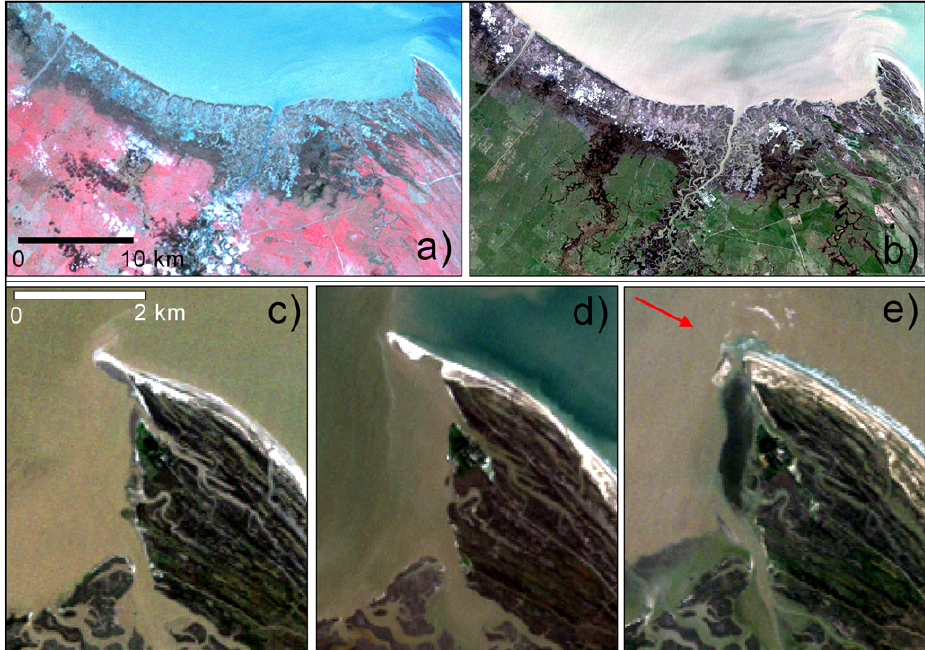
Fig. 5. Landsat images of the southern sector of the Samboromb´on coast acquired on (a) 20 September 1976 and (b) 1 October 2011. Acquisitions dated (c) 13 September 1987, (d) 11 September 2001, and (e) 25 September 2009 show the morphologic evolution of Punta Rasa spit; the red arrow points out the erosion of the spit